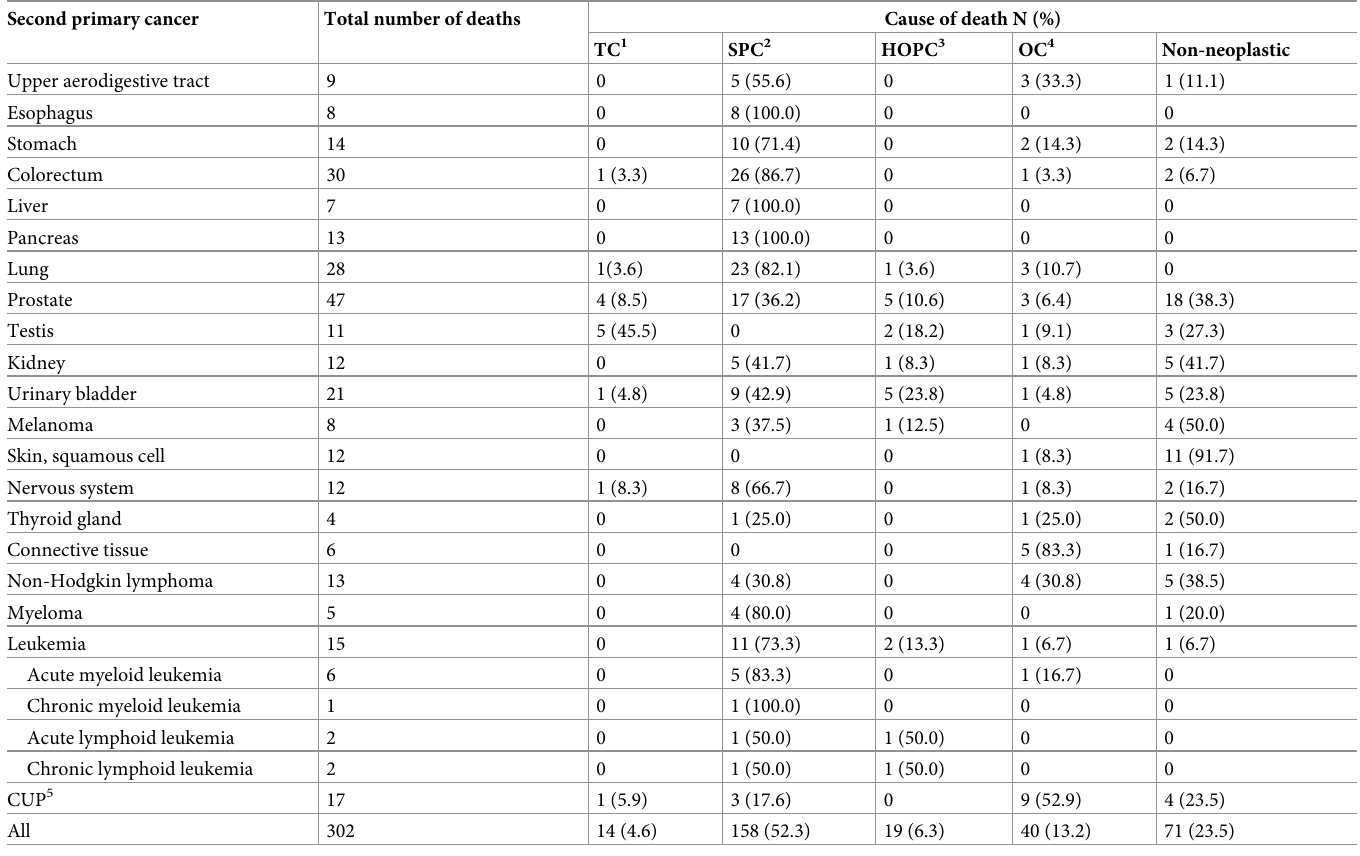
Table 6. Causes of death in patients diagnosed with second primary cancer after testicular cancer.